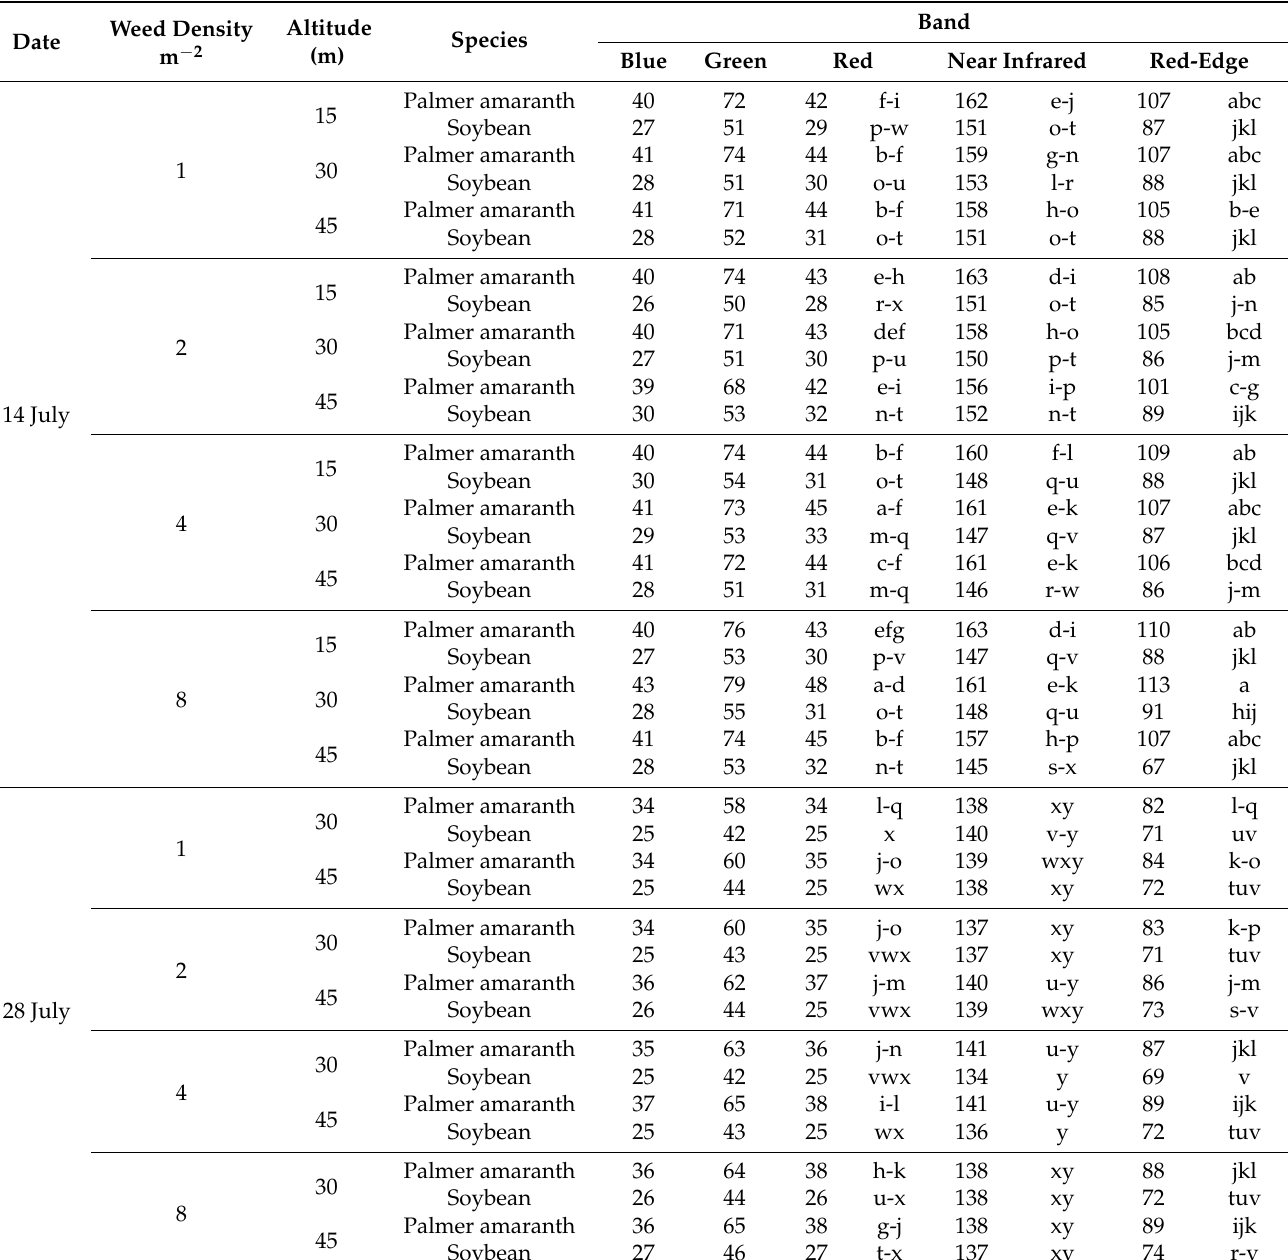
Table 3. Influence of image date, Palmer amaranth density, and altitude on spectral reflectance values of Palmer amaranth and soybean in